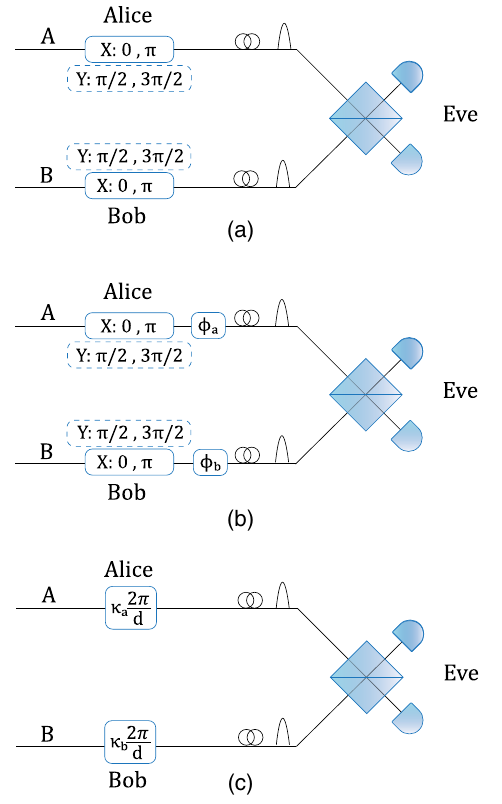
FIG. 10. (a) Schematic diagram of phase-encoding MDI-QKD (Scheme I in Ref. [17]). (b) Schematic diagram of TF-QKD, which is the decoy-state version of the scheme in (a). (c) Sche- matic diagram of d -phase